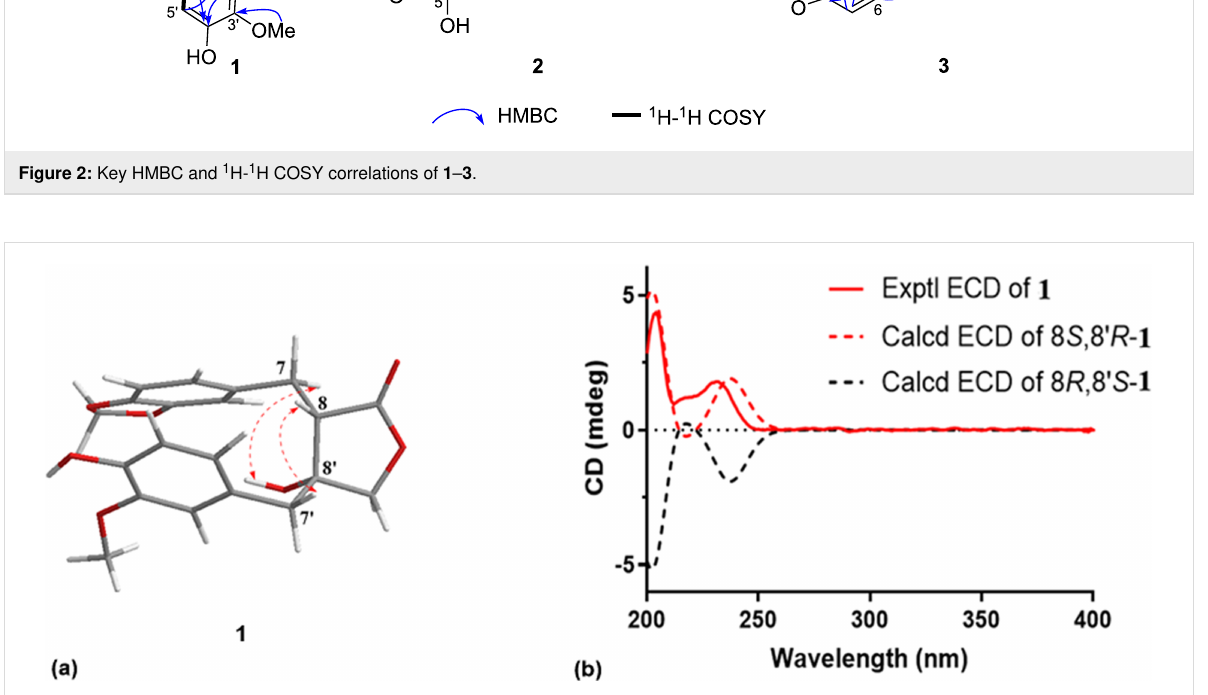
Figure 3: (a) Key ROESY correlations of compound 1 . (b) Experimental and calculated ECD spectra of 1 .